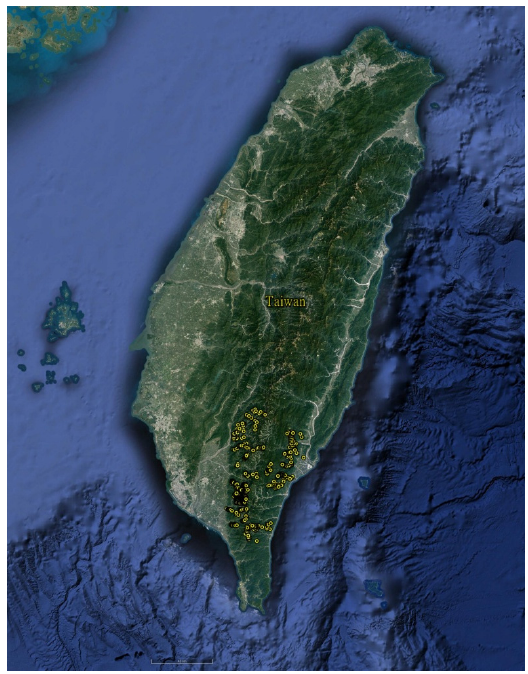
Figure 1. Vegetation relevés in study area (Resource: